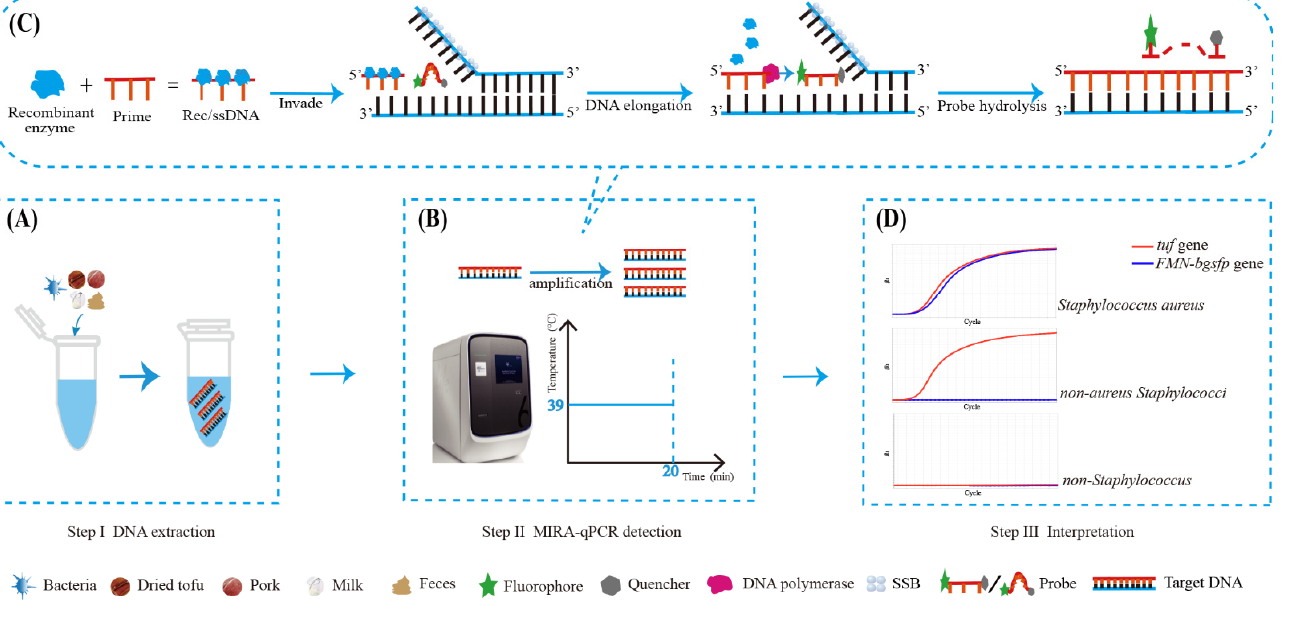
Figure 1. Schematic illustration of the workflow of duplex MIRA-qPCR assay. The detection process can be roughly divided into three steps. ( A ) Step I, the extraction of DNA. ( B-C ) Step II, the ampli- fication and detection of DNA by MIRA-qPCR. ( D ) Step III, the interpretation of fluorescent